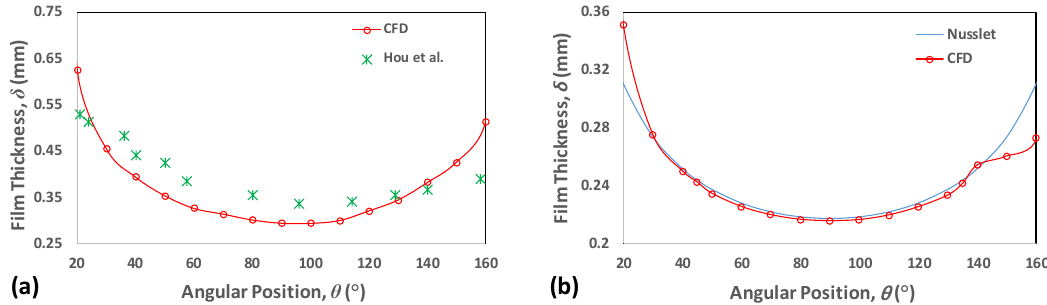
Figure 4. CFD model comparison of ( a ) experimental data by Hou et al. [24] and ( b ) Nusselt solution as in Equation (7).